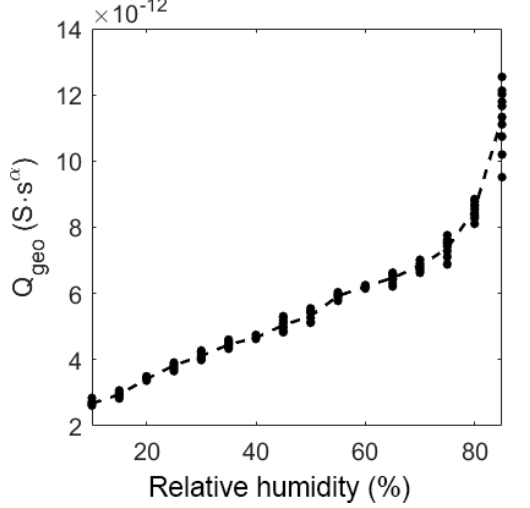
Figure 7. Exponents of every CPE over relative humidity at room temperature. The dots represent the value of the fit of each measure- ment. The dashed lines represent the mean of the dots.